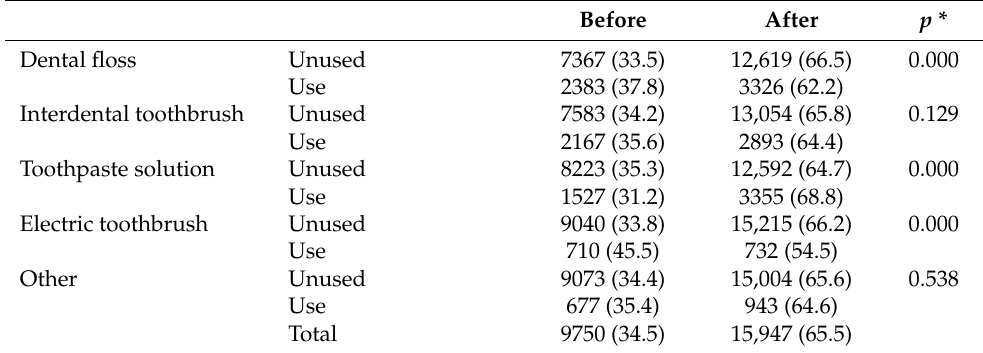
Table 5. Comparison of the subjects’ oral care supplies (Unit: